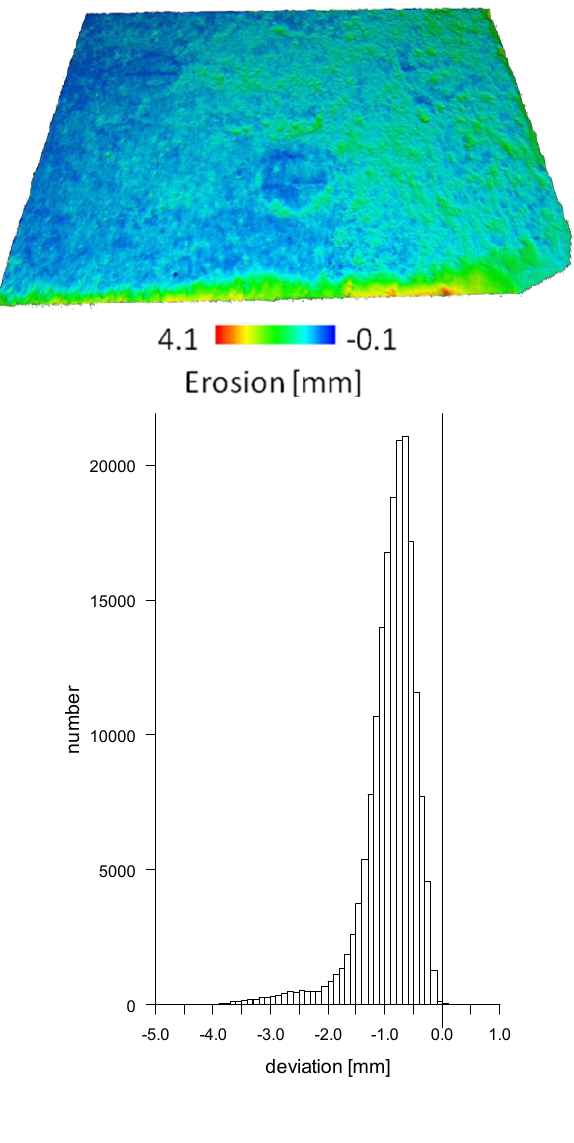
Table 1. Difference DEM of two epochs with no significant erosion, i.e. average difference less than standard deviation ( σ z ) of difference DEM.